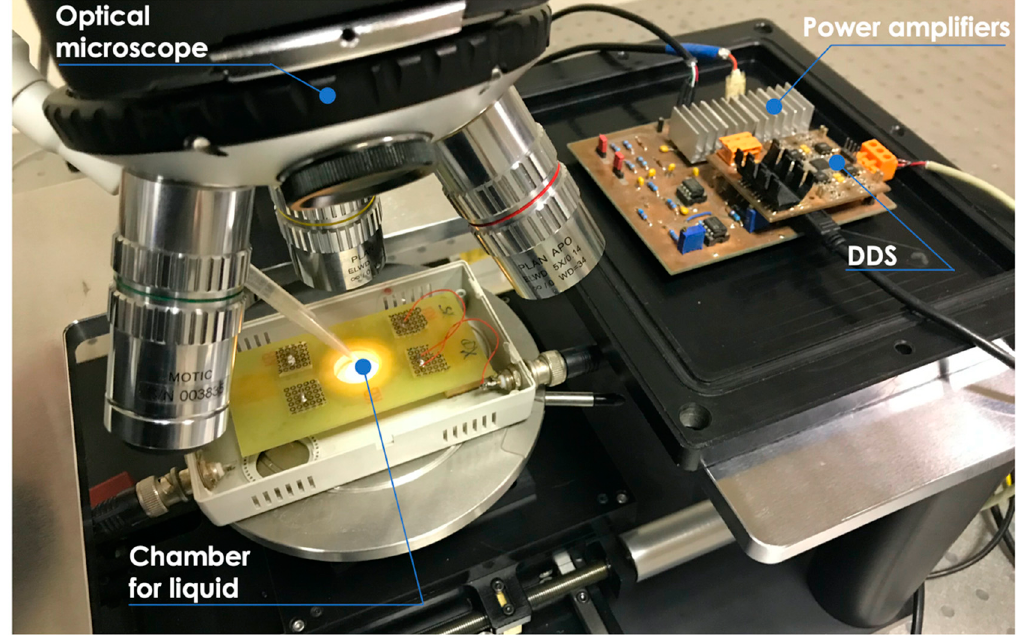
Figure 6. Experimental setup with the device placed under the optical microscope and the tailored electronic interface used to drive the piezoelectric actuators.